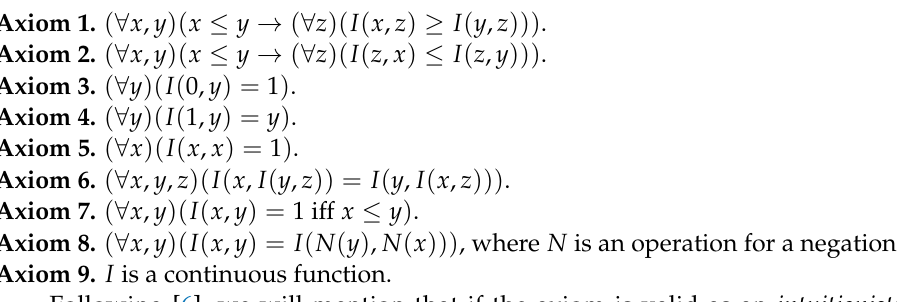
Fig. 5: Geometrical interpretations of elements x A , x B and x A 51